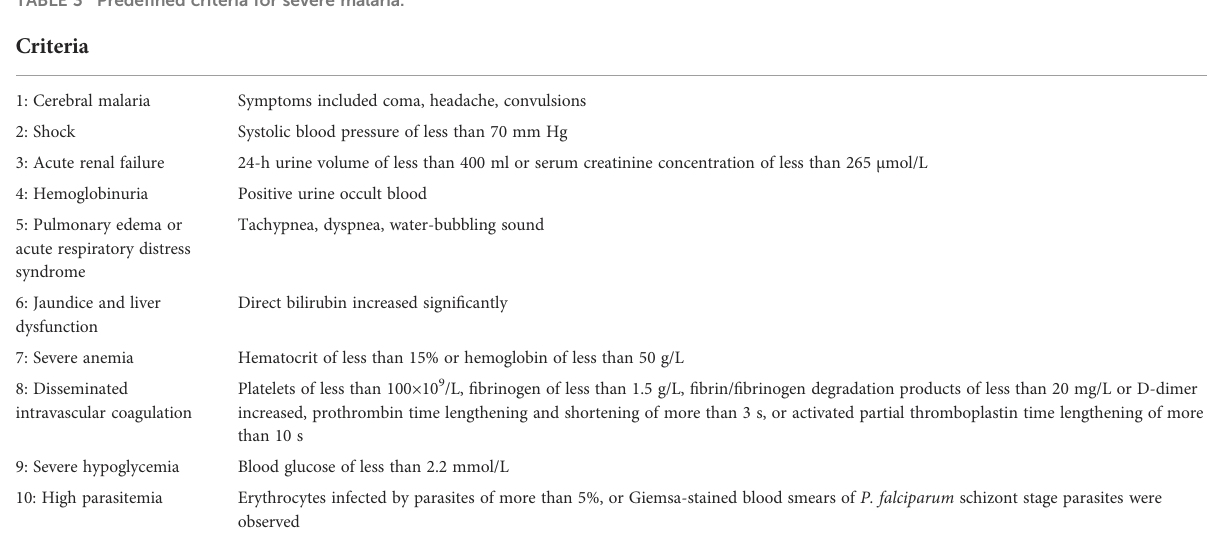
TABLE 3 Prede fi ned criteria for severe malaria.